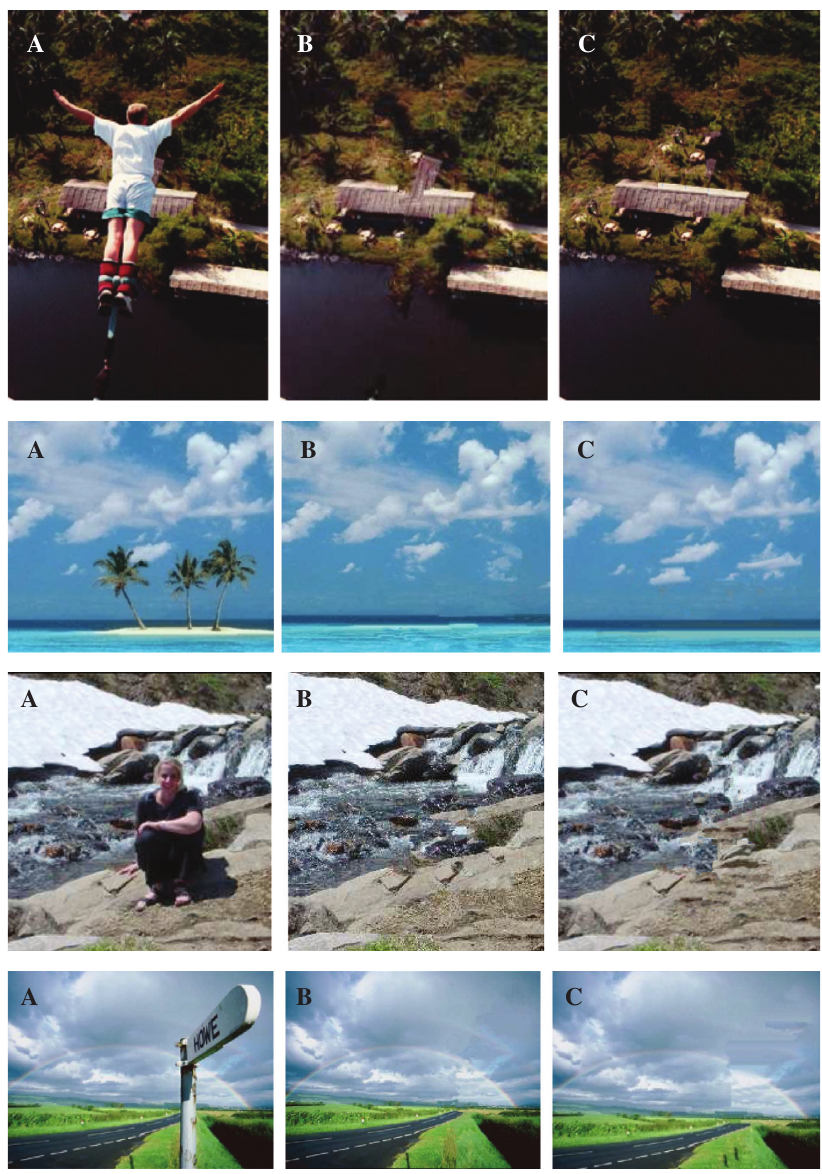
Figure 6. (A) Original Image. (B) Result of Algorithm [8]. (C) Our Algorithm